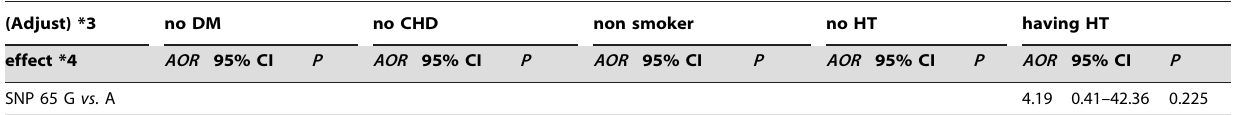
*1.Odds ratios (ORs) were computed by having only SNP variables in the logistic regression. *2.Significant SNPs were selected by backward logistic regression for